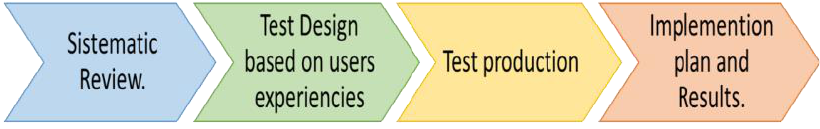
Figure 1. Four-step process to design serious games for health.